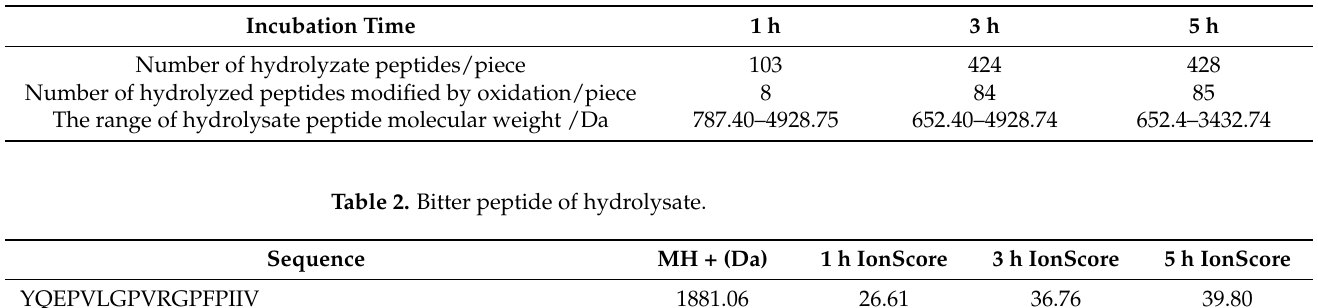
Table 1. LC gradient parameters.